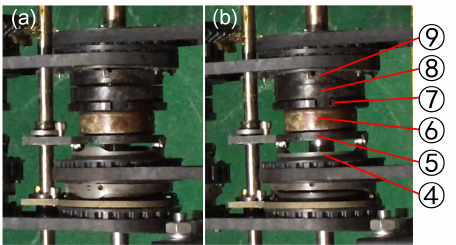
Figure 15. The slider assembly unit. ( a ) shows the master clutch (Part 8 (cid:13) ) and slave clutch (part 9 (cid:13) ) separate from each other. In ( b ), they have been meshed with each